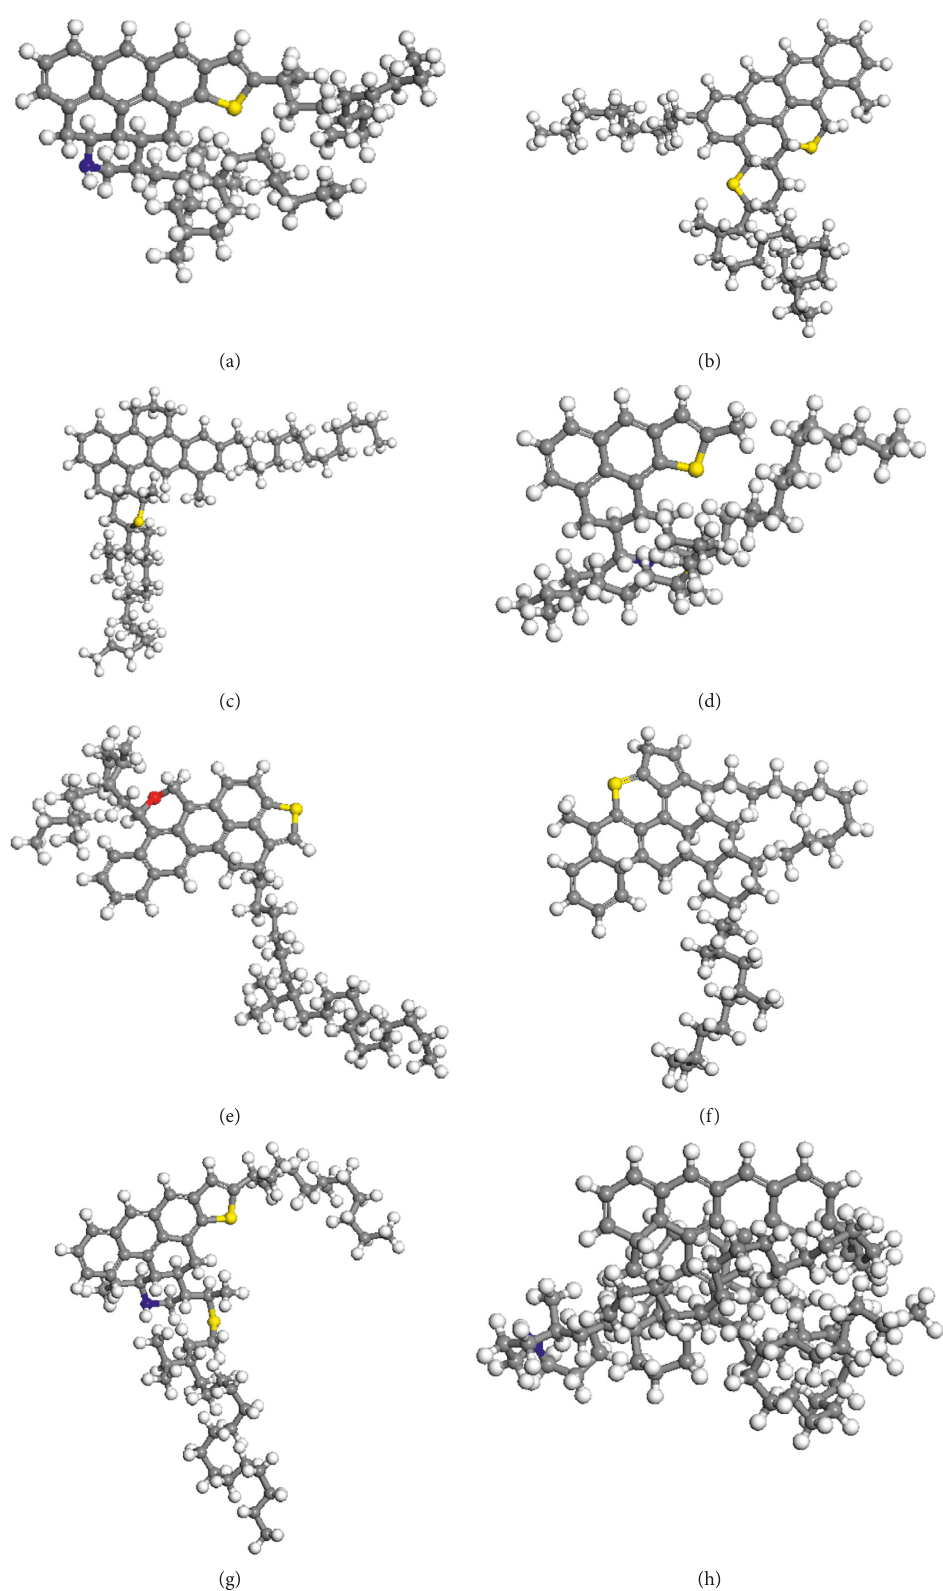
Figure 3: Average molecule for each of the SHRP binders [59]: (a) AAA-1, (b) AAB-1, (c)AAC-1, (d) AAD-1, (e) AAF-1, (f) AAG-1, (g) AAK-1, and (h)